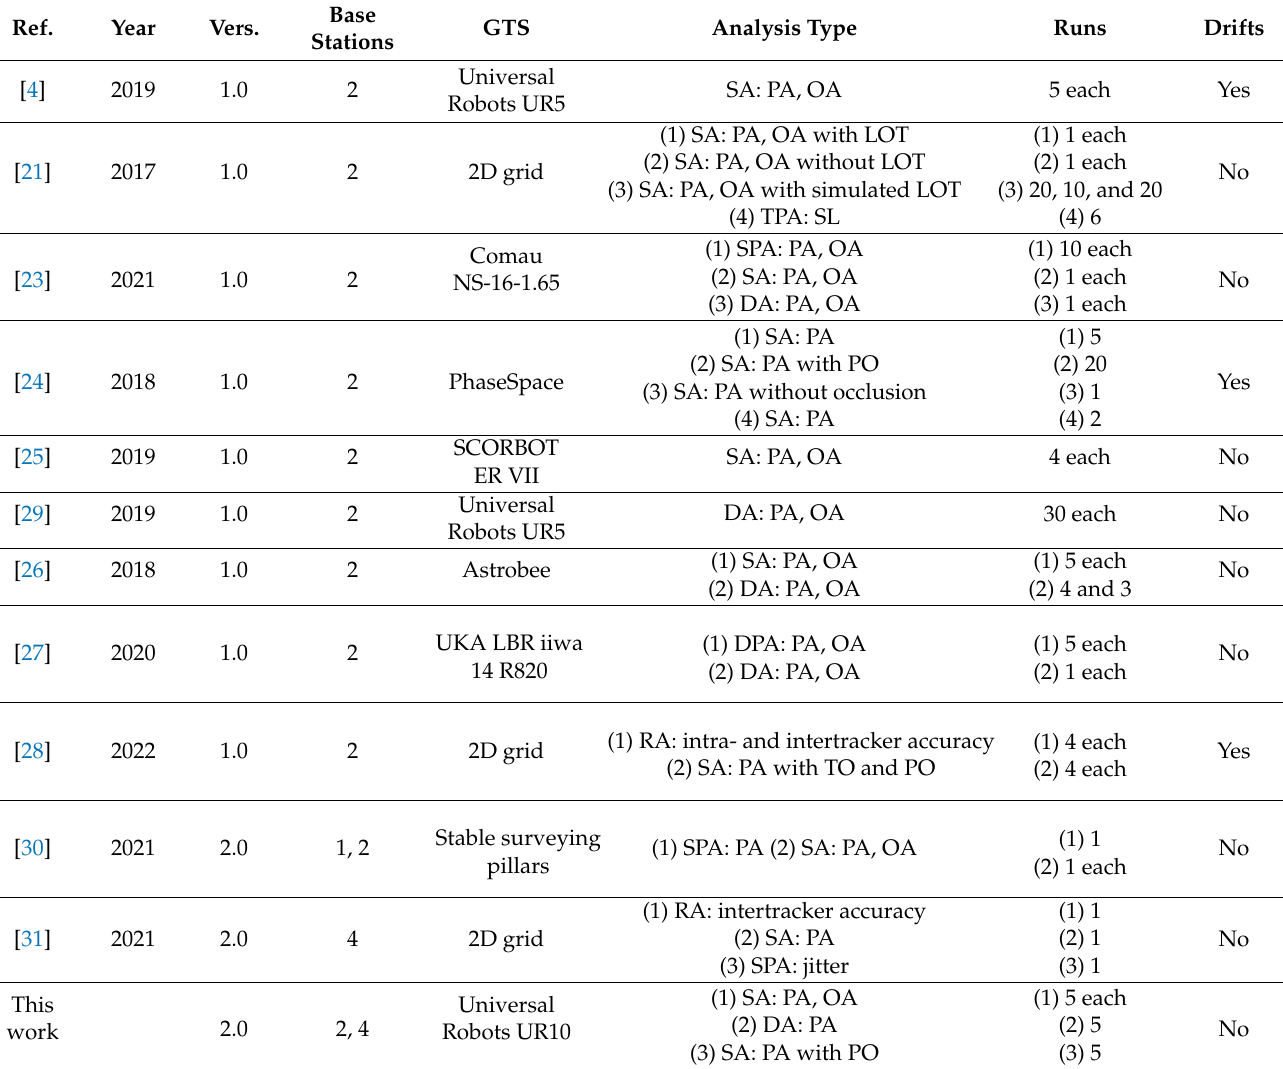
Table 1. Related work overview stating used SteamVR Tracking version, number of base stations, GTS, analysis types, number of measurement runs, and occurrence of positional drifts.